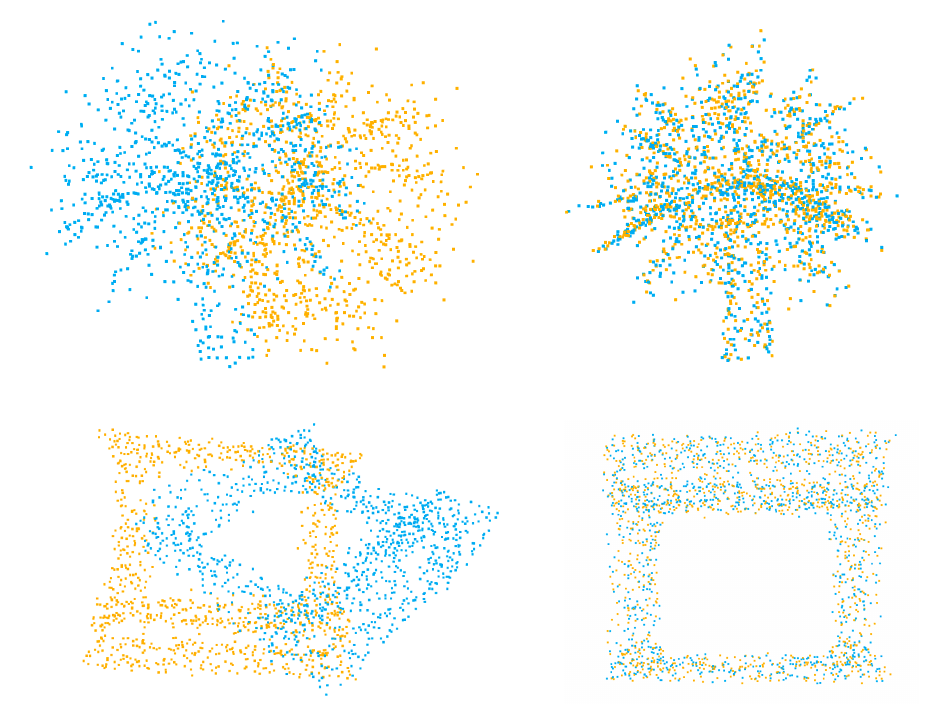
Figure 4. Qualitative results of point clouds with Gaussian noise.